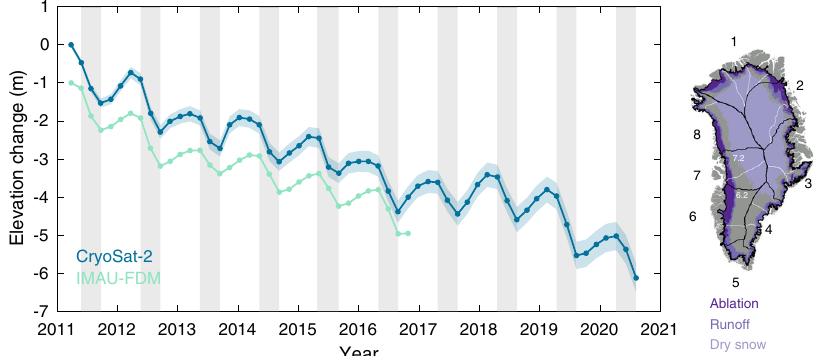
Fig. 2 Surface height evolution in the ablation zone of the Greenland Ice Sheet, 2011 – 2020. (left) Elevation change time-series derived from CryoSat-2 altimetry (dark blue, shaded region represents the estimated 1 σ uncertainty) and the Institute for Marine and Atmospheric Research Utrecht Firn Densi fi cation Model (IMAU-FDM) (light blue) for the ice sheet ablation zone between January 2011 and October 2020. IMAU-FDM time-series have been offset by 1 m for ease of viewing. (right) De fi nition of ice sheet facies and principal drainage basins (black) and sub-basins (white) 39 used in this